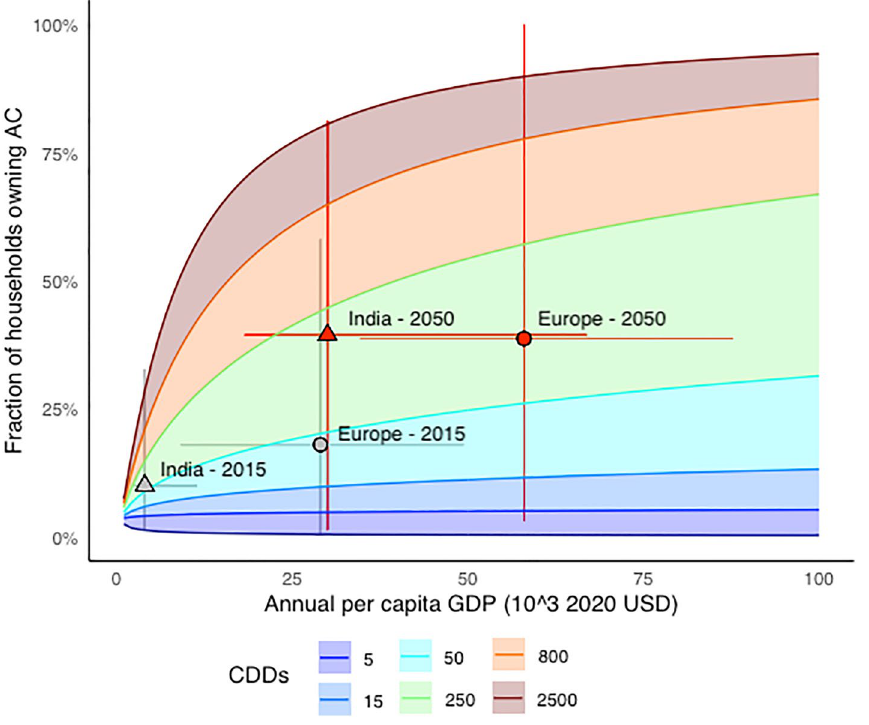
Figure 1. The combined effects of income and heat exposure on AC prevalence. Color ranges represent the income-AC curves at different levels of exposure to CDDs under the median urbanization level. Points represent the observed regional AC ownership rates, as well as the prediction at mid-century under RCP 8.5 and SSP 5. Regions’s vertical movements between zones with different colors indicate variations in AC prevalence due to an increase in the exposure to long-run CDDs, horizontal movements within zones of a given color indicate the effect of higher annual per capita income. Error bars indicate the 10th–90th quantile of per capita income (horizontal) and AC prevalence (vertical) across the States in the two regions in 2015 and circa 2050.